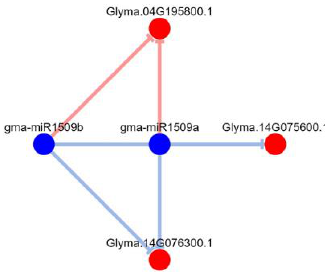
Figure 9. Degradome-based gma-miR1510b-5p/3p–target interactions and network. Note: we used DPMIND software (http://cbi.njau.edu.cn/DPMIND/network.php?race_id=3847, 1 January 2022) to obtain the network. Note: blue circles indicate miRNA, red circles indicate targets, red lines indicate strong evidence, blue lines indicate weak evidence.